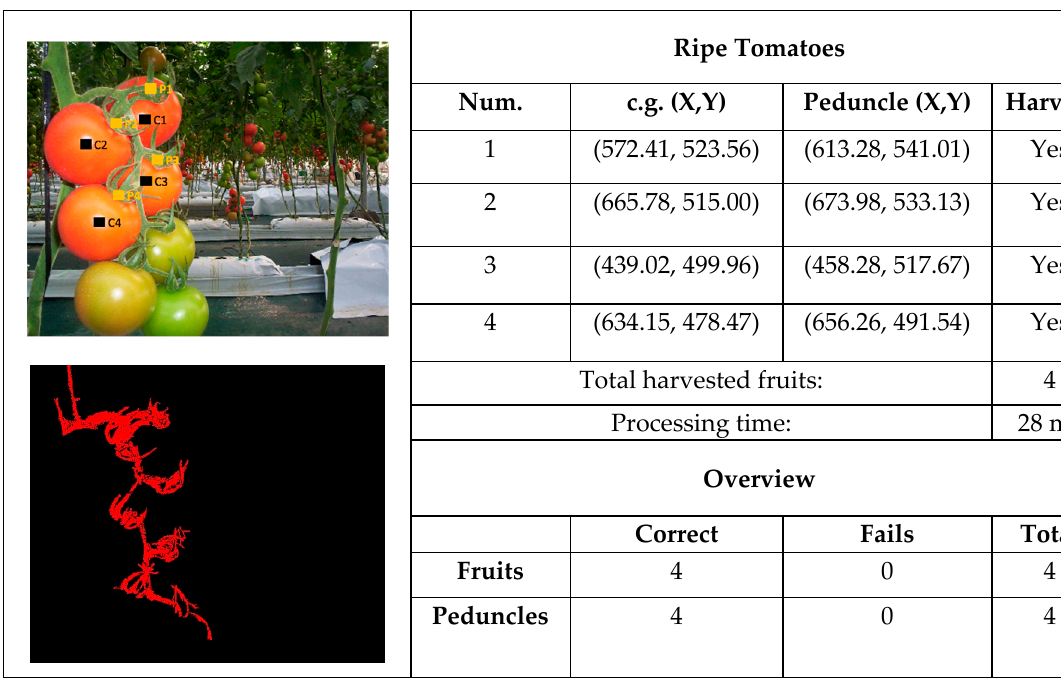
Figure 21. Convex area centers, peduncle detection and results.